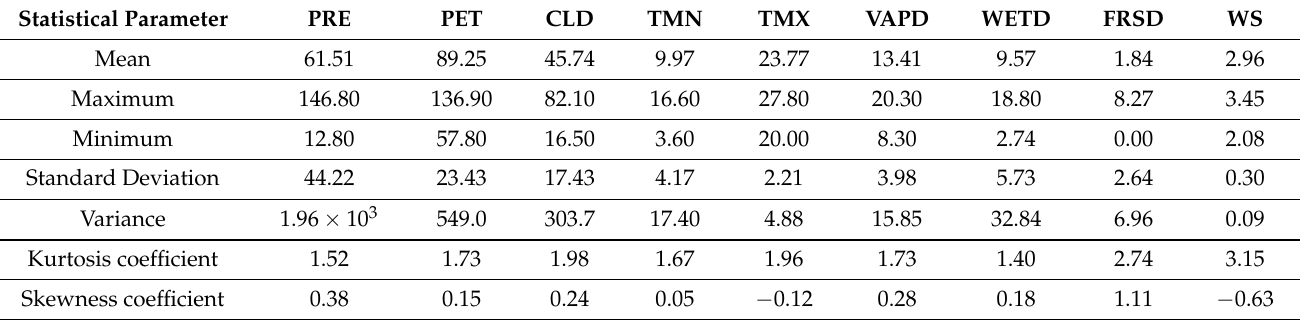
Table 2. Statistics of data used in the